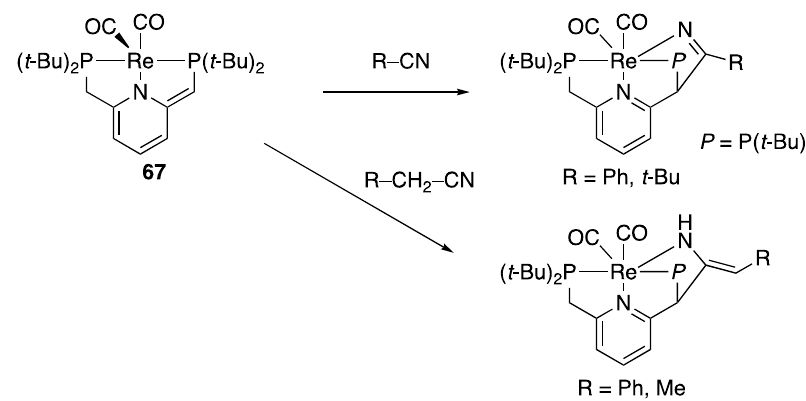
mechanisms were proposed for the Mn- and Re-catalyzed